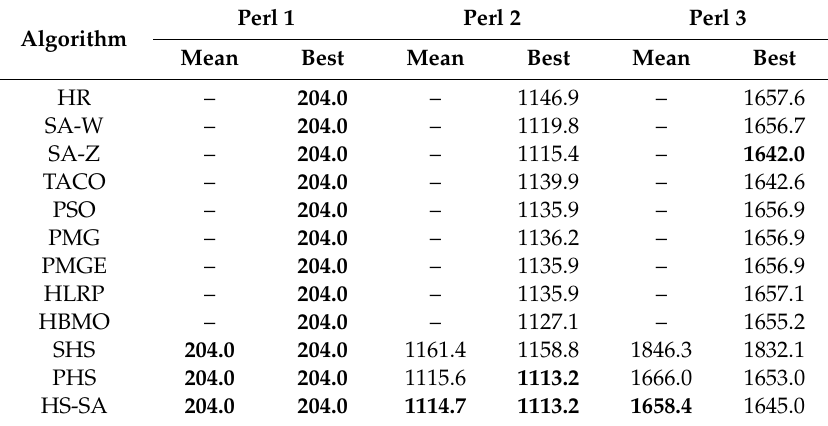
Table 3. Comparative results of Perl dataset for LRP.